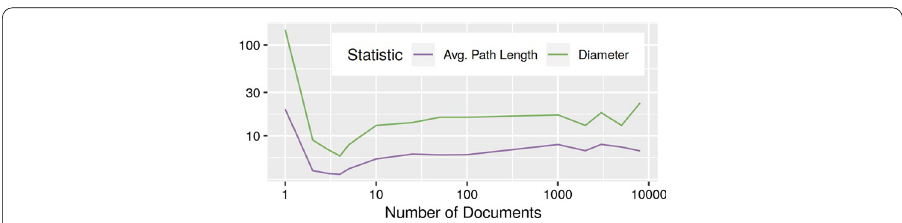
Fig. 15 Average estimated diameter and average shortest path over time for the synonyms